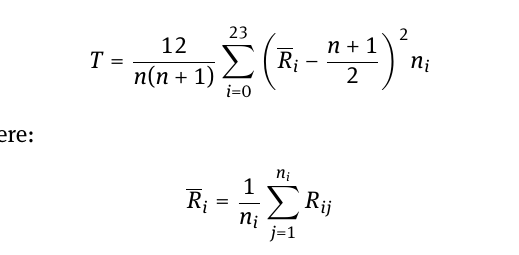
The values of the Kolmogorov-Smirnov test statistic on their own do not allow to group similar groups into clus- ters. To determine clusters, we used the Multidimensional Scaling Method followed by K-means Cluster